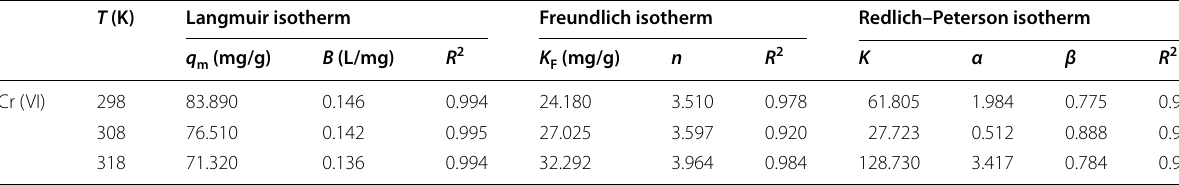
Table 2 Isotherm parameters for the adsorption of chromium